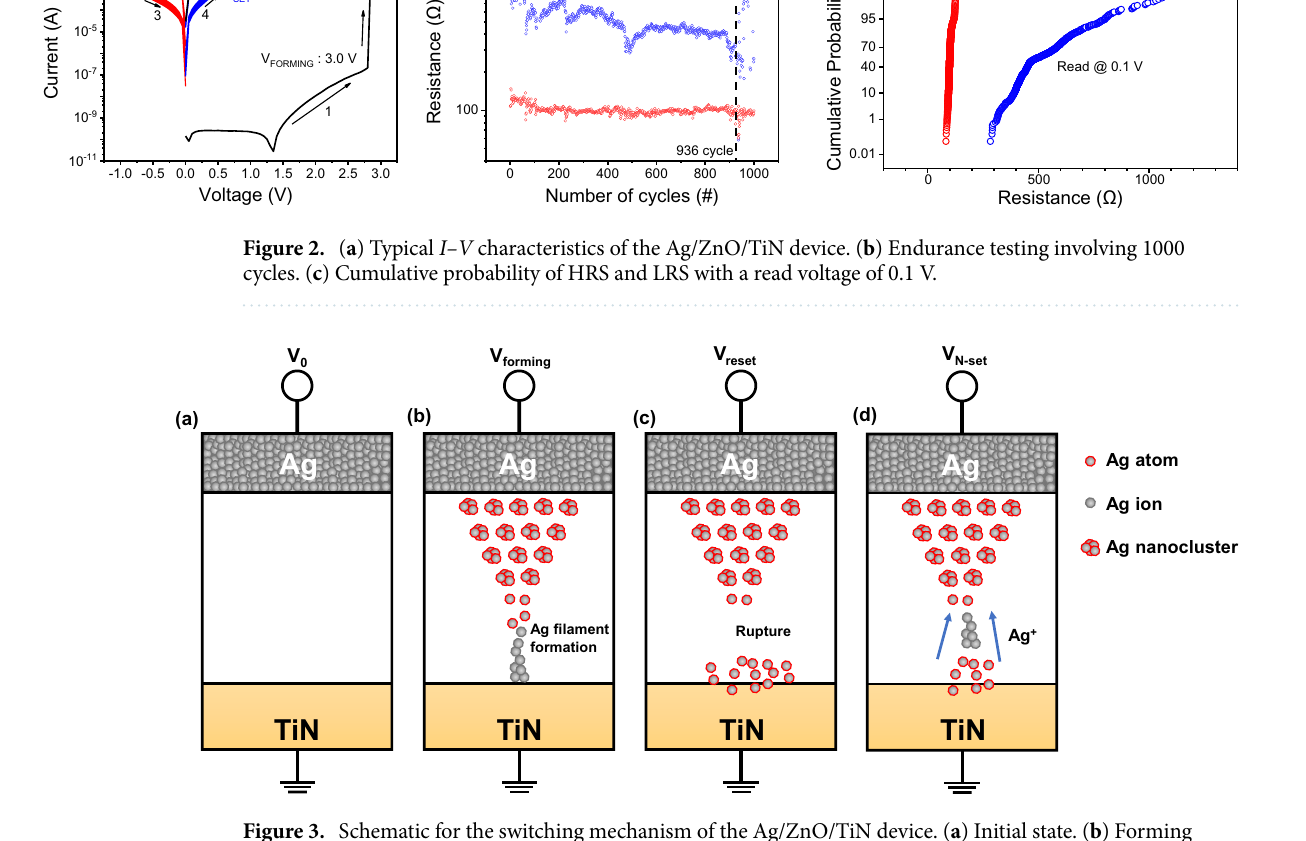
Figure 3. Schematic for the switching mechanism of the Ag/ZnO/TiN device. ( a ) Initial state. ( b ) Forming state. ( c ) Reset state. ( d ) Negative-set